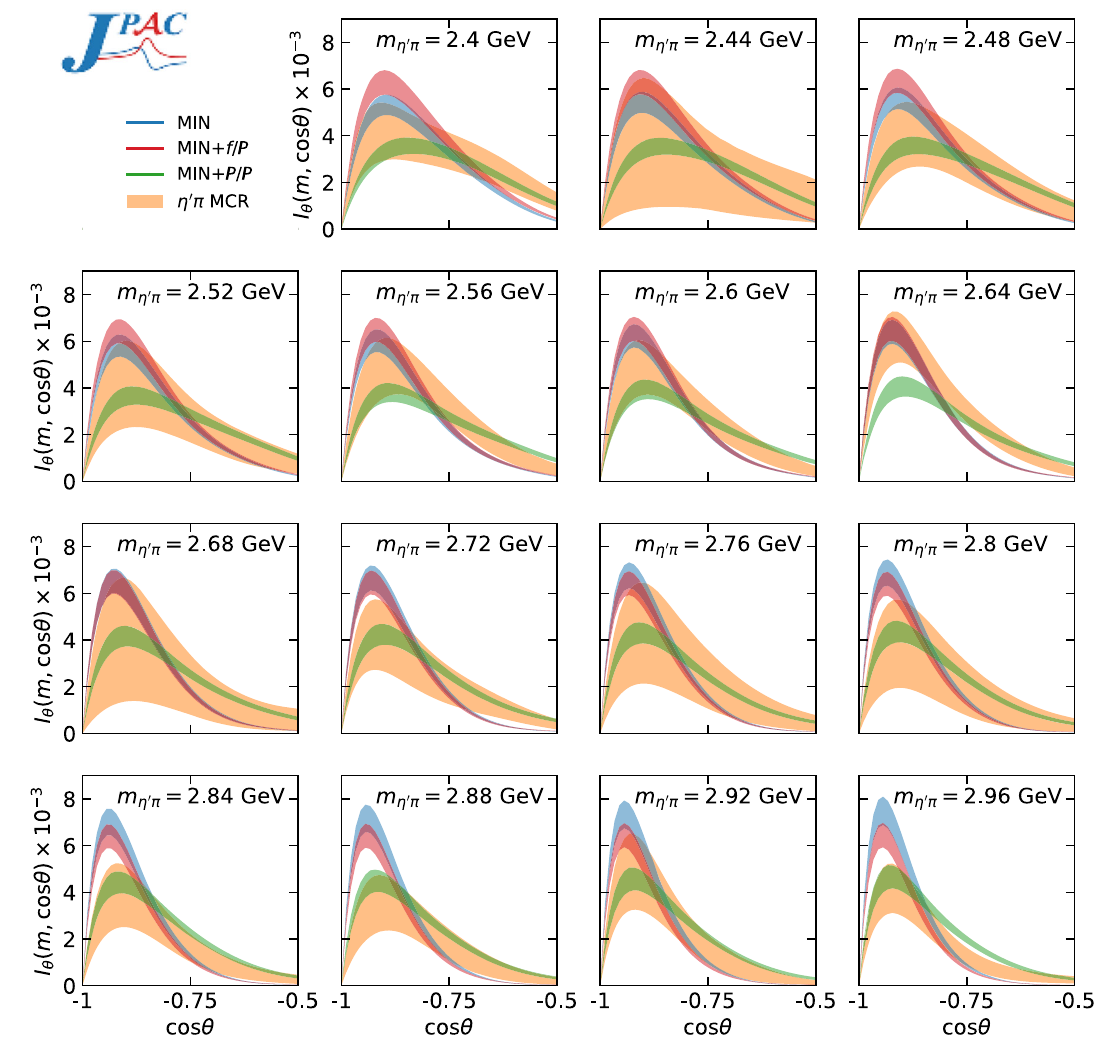
Fig. 17 Same as Fig. 13 for η (cid:2)